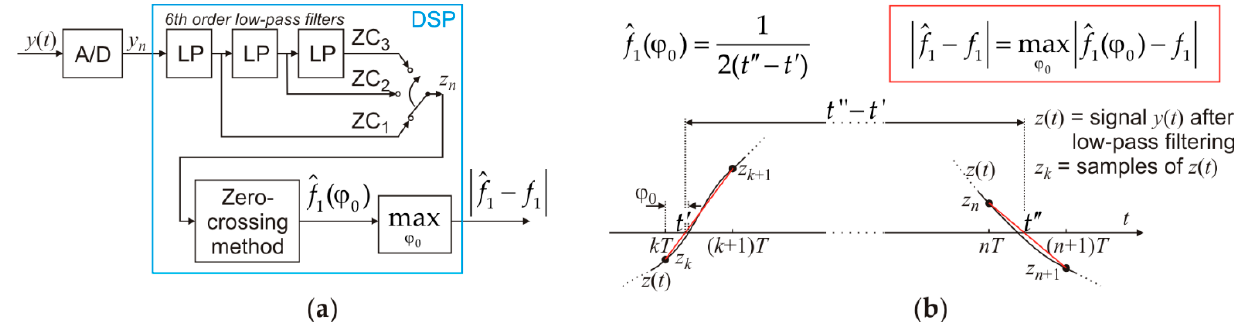
(cid:12) (cid:12) ˆ f (cid:12) (cid:12) − f 1 1